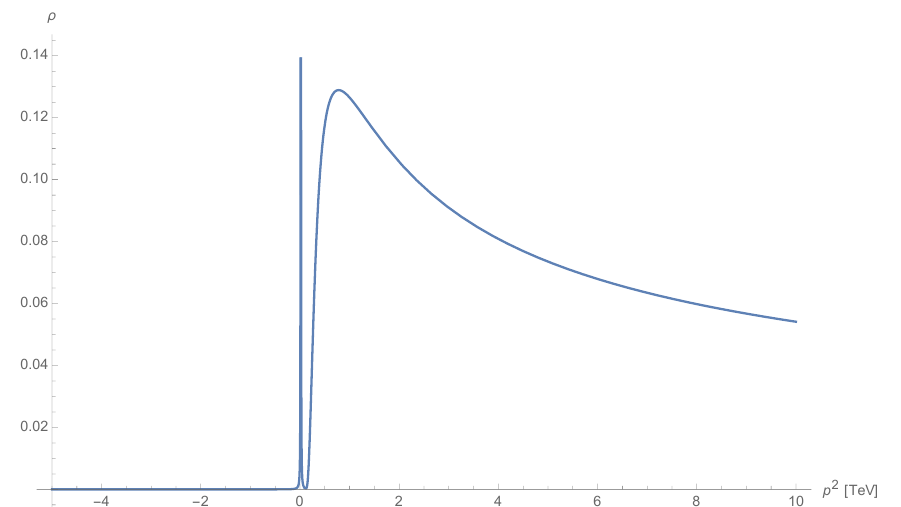
Figure 1. The Higgs spectral density function, for (cid:22) = 300 GeV and (cid:1) = 1 :